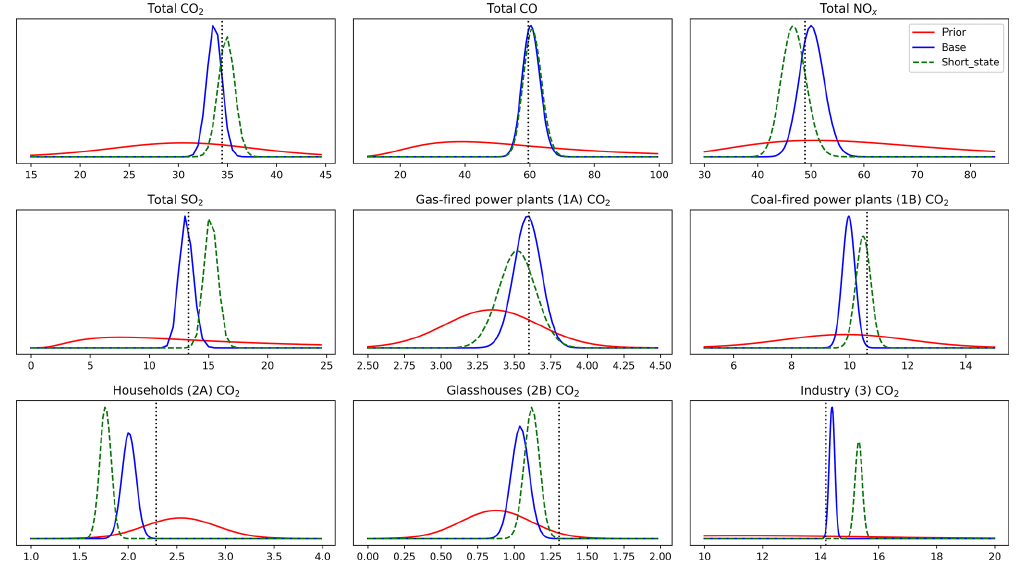
Figure 10. Probability density functions of emissions per species or per source category (for CO 2 ) in units of teragrams (Tg) (CO 2 ) or gigagrams (Gg) (CO, NO x , SO 2 ). The truth is shown as a vertical dotted line, typically well matched by the mean of the posterior in blue. Using a shortened state vector (green dashed line) deteriorates the total non-CO 2 emissions substantially and leads to misattribution of CO 2 emissions in minor categories such as 2A